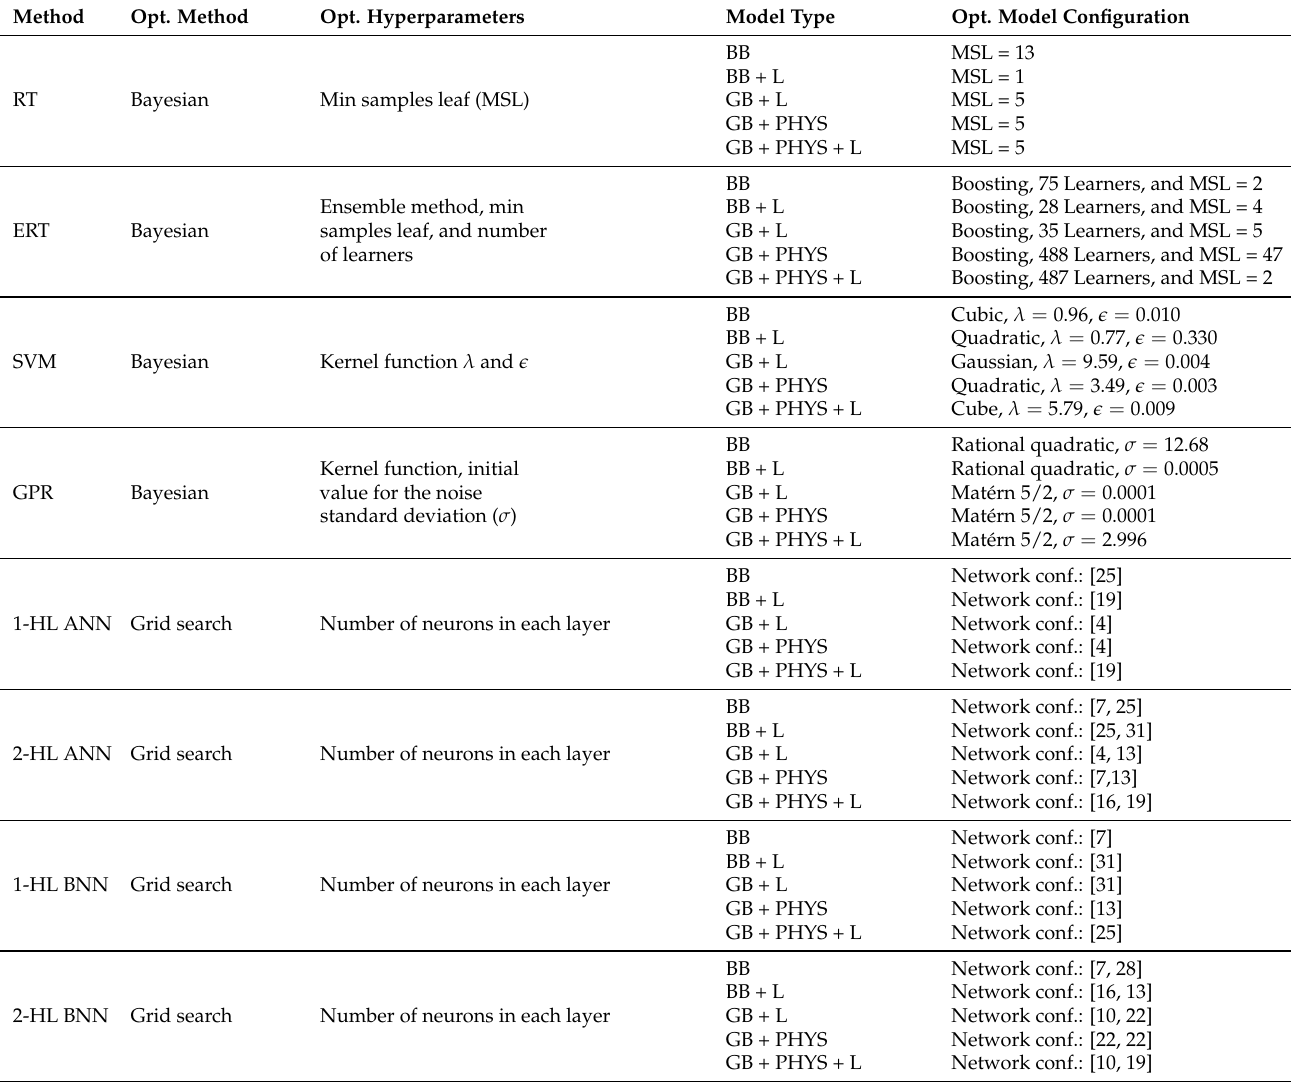
Table 3. Training and optimization of ML-based model hyperparameters. In this table MSL is minimum samples leaf for regression tree and ensembles trees methods, λ is the regularization parameter and (cid:101) is the maximum tolerable deviation for support vector machione method, and σ l is the length scale of Gaussian process regression